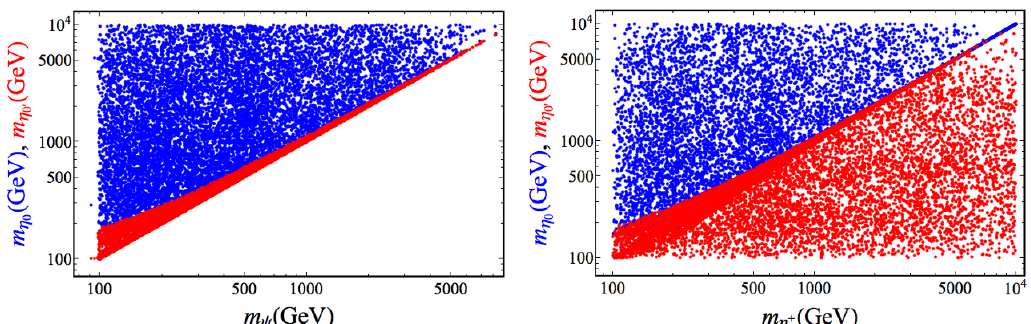
Figure 6 . The lighter and heavier neutral scalar masses, m versus the dark matter mass m in the left panel, and versus the charged scalar mass m (cid:17) + in the right